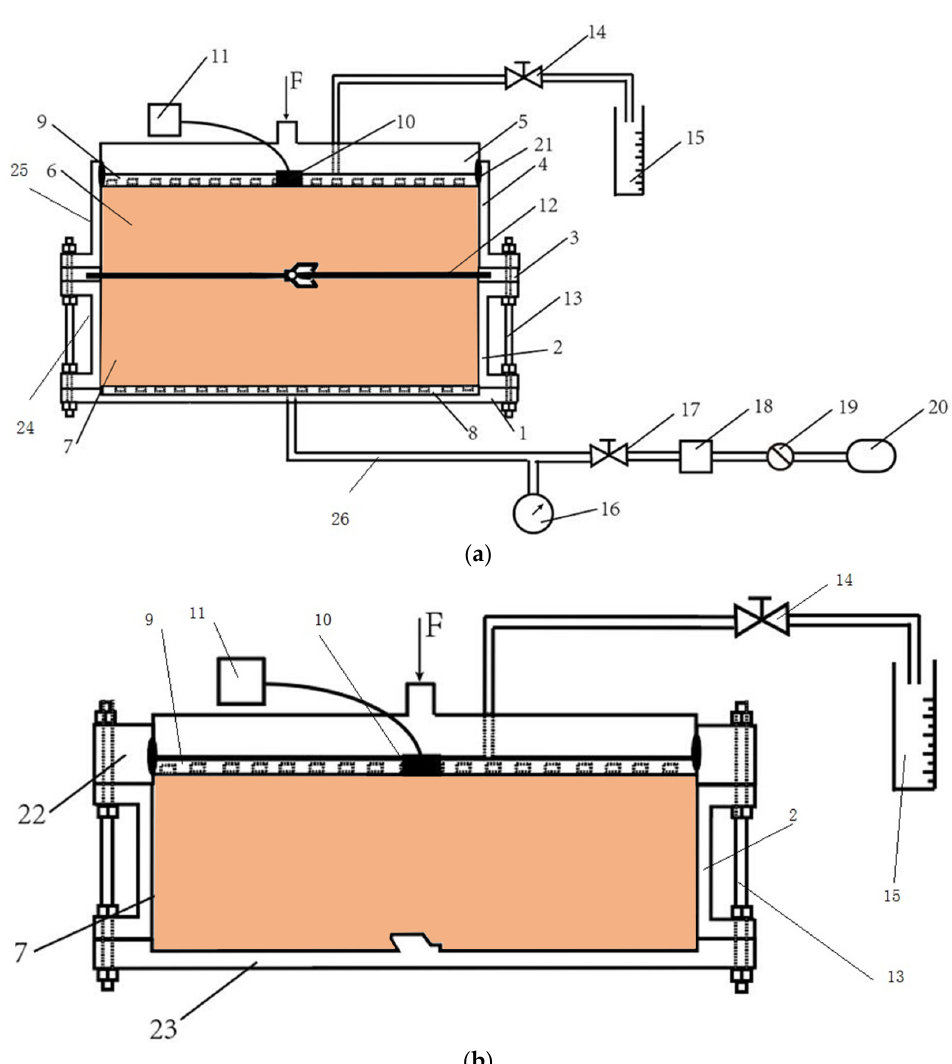
Figure 3. The schematic of ( a ) a flow rates model testing apparatus, and ( b ) a consolidation model testing device used in this study.